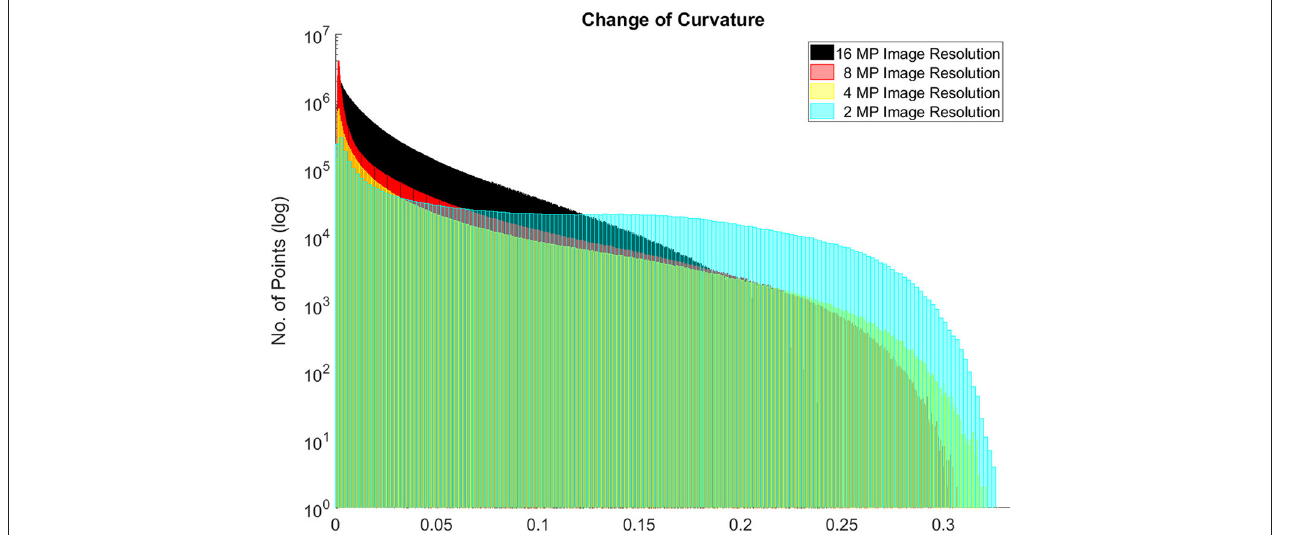
FIGURE 11 | Comparison of curvature values in models generated using different image resolutions.